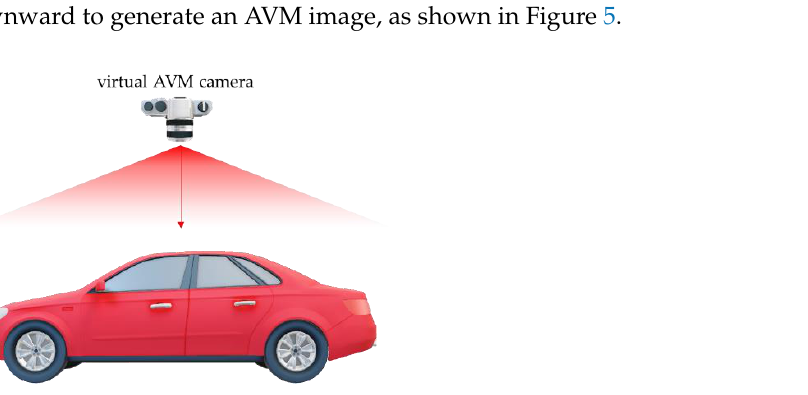
Figure 5. Visualization of the orientation and location of the virtual AVM camera.